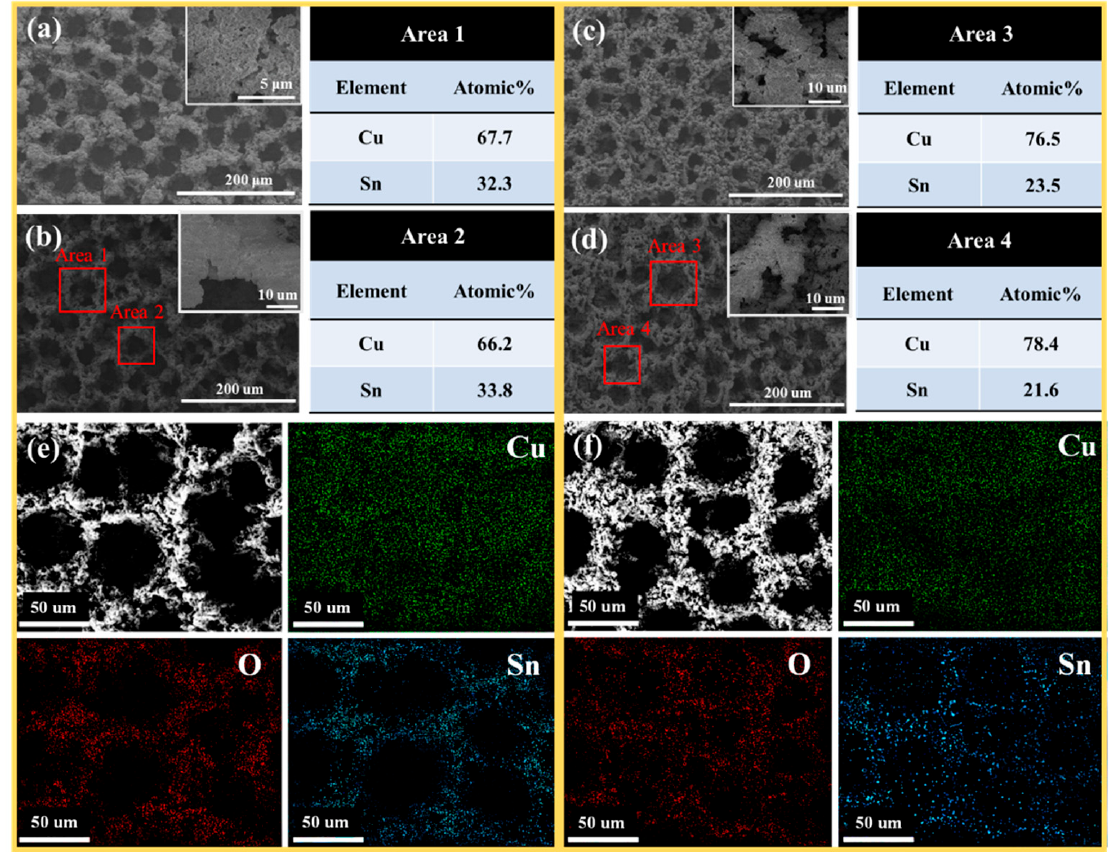
Figure 2. Typical SEM images of ( a ) Cu / SnO 2 before pre-reduction; ( b ) Cu / SnO 2 ; ( c ) A-Cu / SnO 2 before pre-reduction; ( d ) A-Cu / SnO 2 . SEM elemental mapping of ( e ) Cu / SnO 2 and ( f ) A-Cu / SnO 2 . The table is EDX analysis identifying.